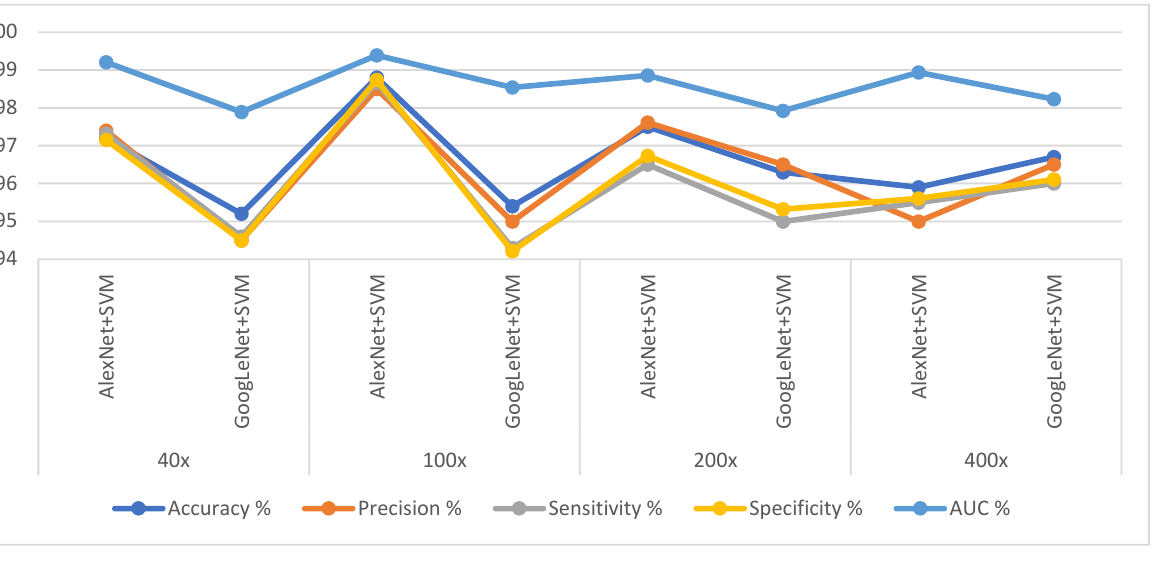
and 96.7% for diagnosing malignant tumors.